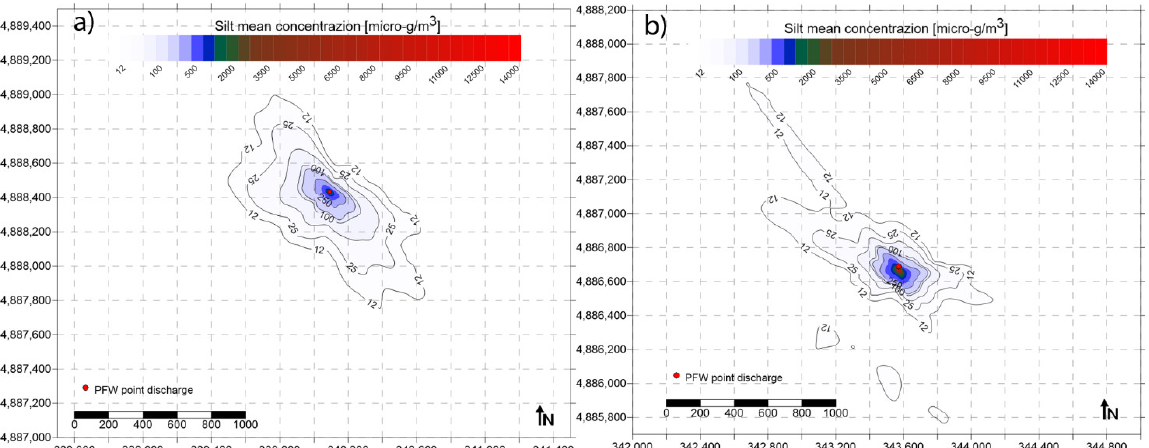
Figure 14. Map (WGS 84 UTM 33N) of monthly mean concentration of silt suspended as result by MIKE 3 PT module output for ( a ) Plt A at 10 m depth and ( b ) Plt B at 20 m depth.